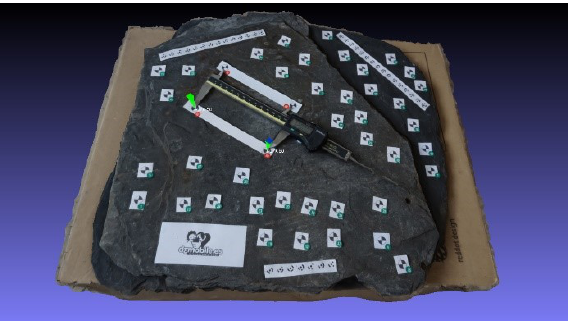
Figure 6. A randomly scaled 3-D model provided to the students for the metrology test. The model includes 40 numbered targets and a calliper as a reference for students, as well as a set of 12- bit coded targets for precise and automatic image